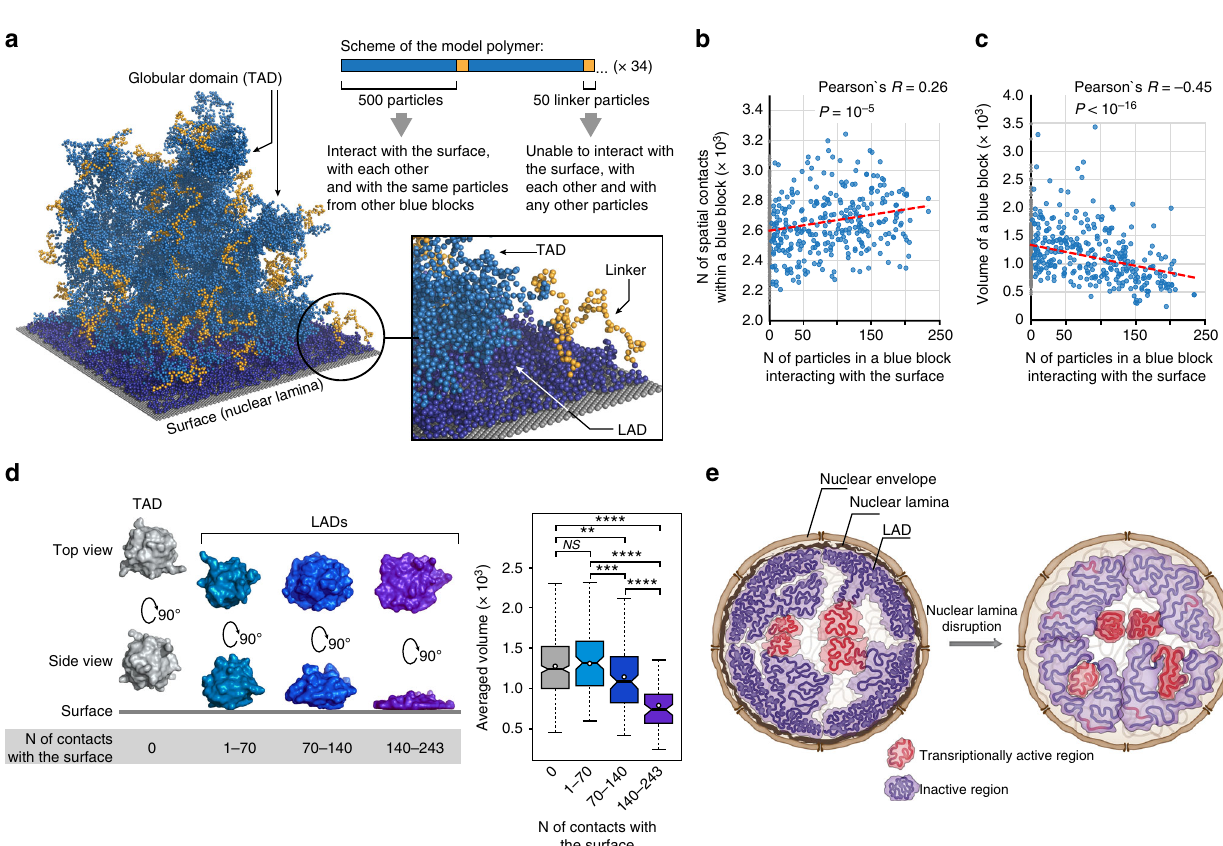
Fig. 6 Model polymer simulation shows that the attachment to the NL is suf fi cient for chromatin compaction. a Scheme of the model polymer (MP) and visualisation of its conformation derived from a simulation run. Blue particles are able to interact with each other and with the surface recapitulating properties of non-acetylated nucleosomes in the inactive chromatin. Orange particles are unable to interact with any particles and with the surface recapitulating properties of acetylated nucleosomes in active chromatin. MP is composed of 68 blue and 68 orange particle blocks. Blue blocks with at least one particle contacting the surface are coloured with dark blue and considered as LADs. b The number of spatial contacts between particles in a blue block depends positively on the number of particles in this block contacting the surface. Trend line is in red. c The volume of a blue block depends inversely on the number of particles in this block contacting the surface. Trend line is in red. d Averaged 3D structures of blue blocks with a different number of contacts with the surface (left panel). Box plots (see Fig. 1g legend for description of their elements) show the decrease of LAD volume with the increasing number of contacts with the surface (right panel). **** P < 0.0001, *** P < 0.001, ** P < 0.01, NS non-signi fi cant difference ( P > 0.05) in a Wilcoxon test. e